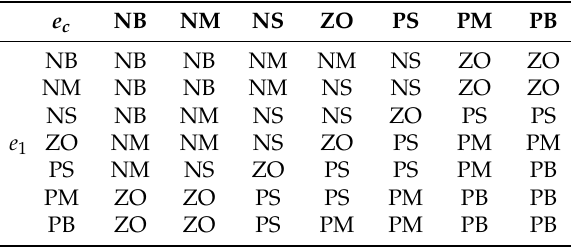
Table 2. The rules base of FLC for ∆ γ 1